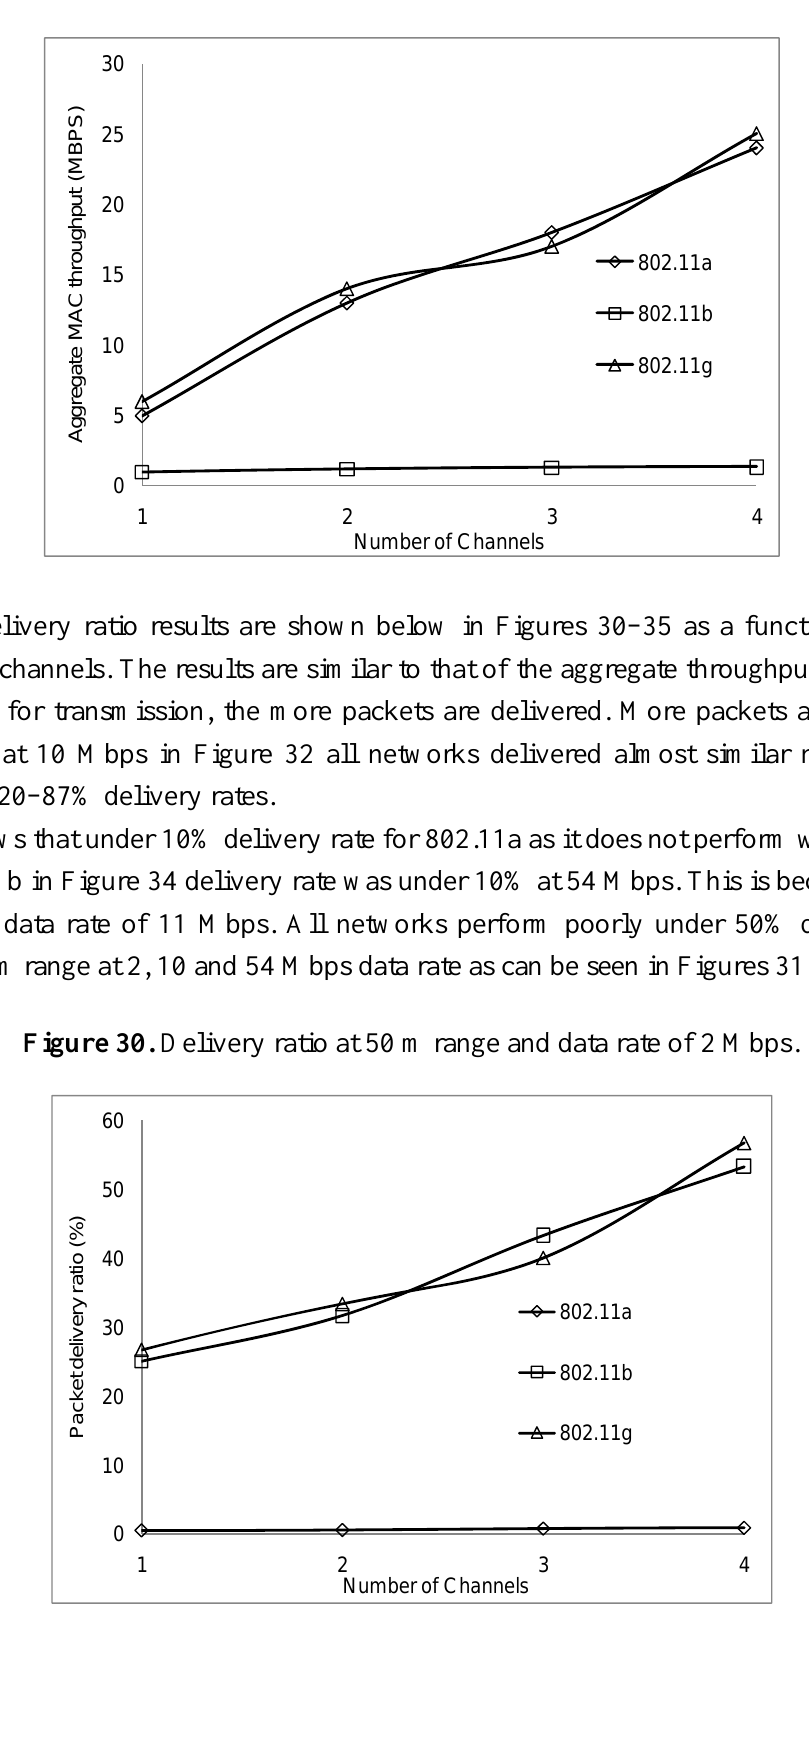
Figure 29. Aggregate throughput at 100 m range and data rate of 54 Mbps.